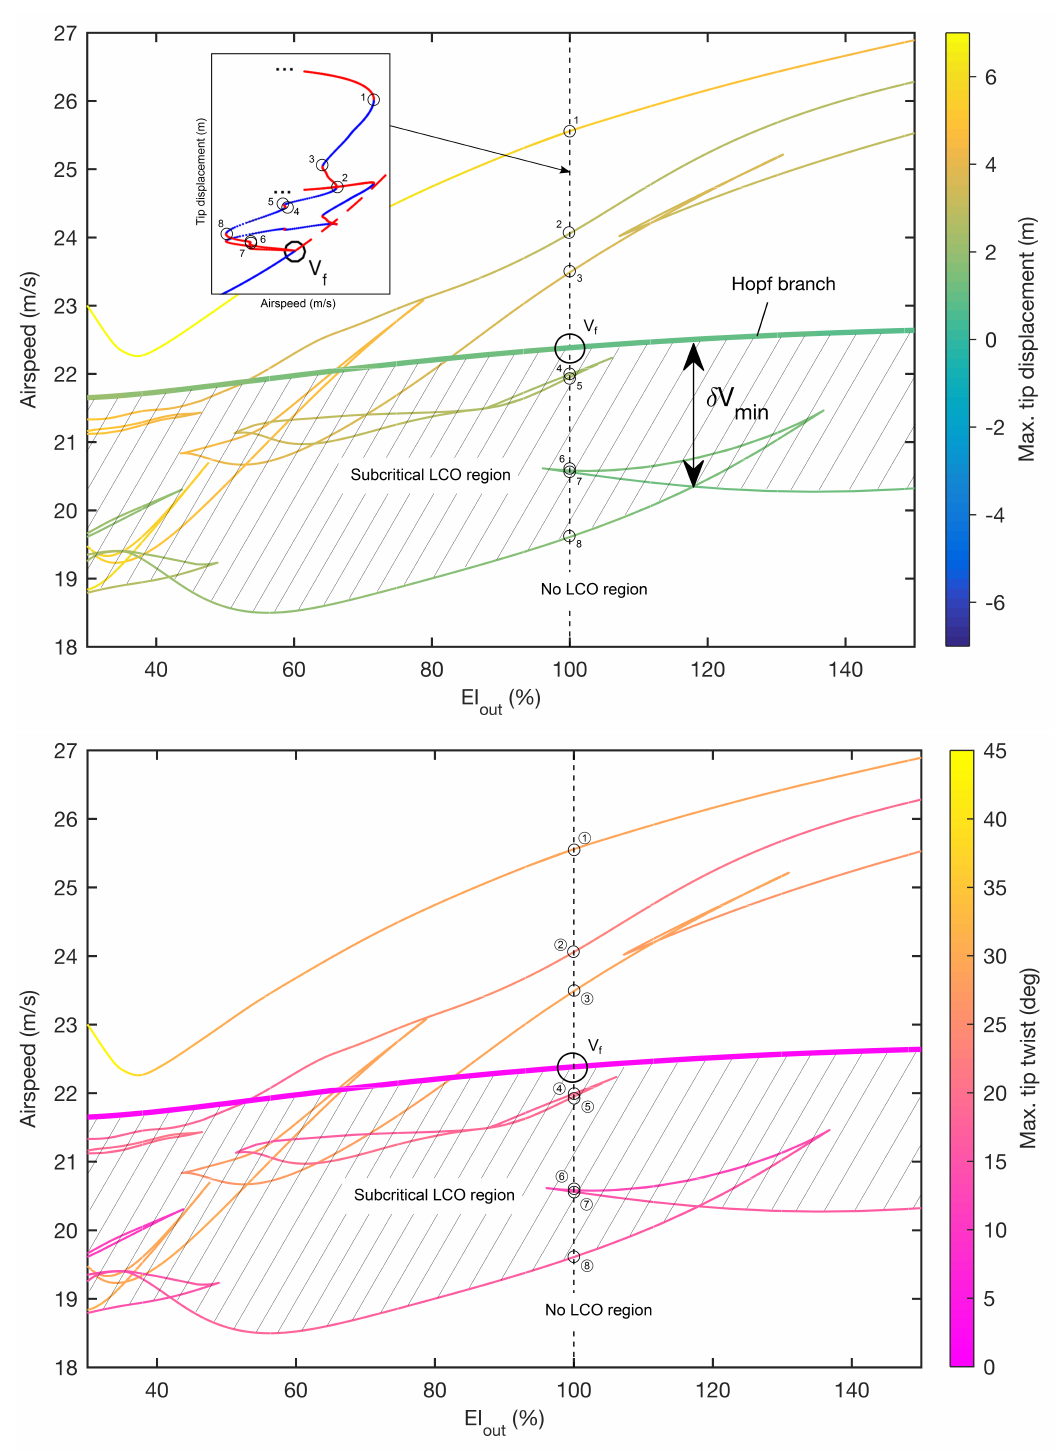
Figure 12. Two-parameter continuation of Hopf points and periodic folds for varying out-of-plane stiffness. The shaded region indicates where subcritical LCOs exist in the